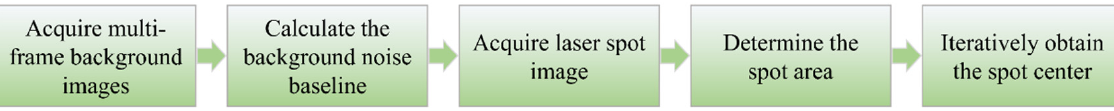
Figure 1. Image acquisition.